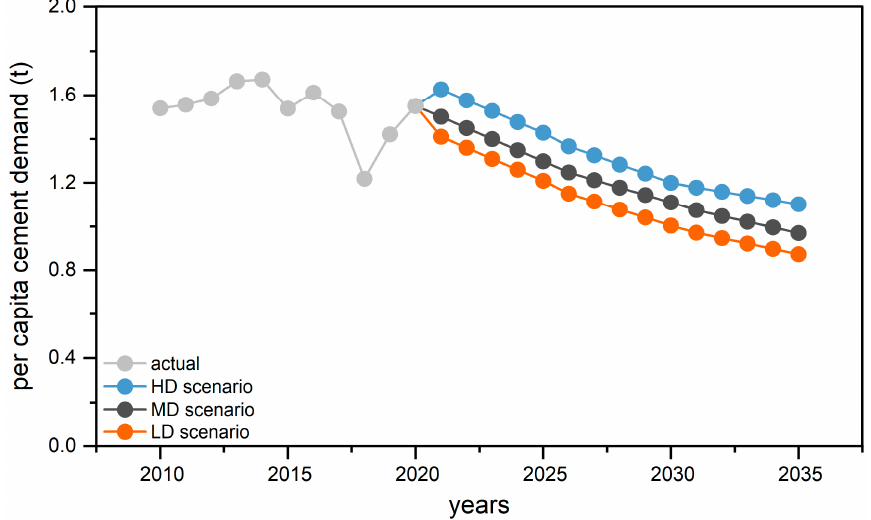
Figure 2. Per capita cement demand in Shandong Province under different scenarios.